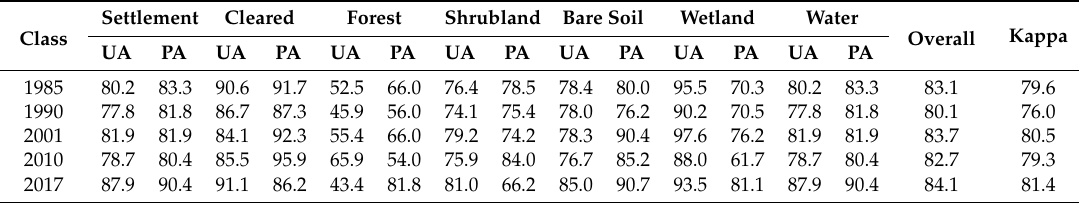
Table A2. User’s accuracy (UA, %), producer’s accuracy (PA, %), overall accuracy (%) and Kappa coefficient (%) for LULC